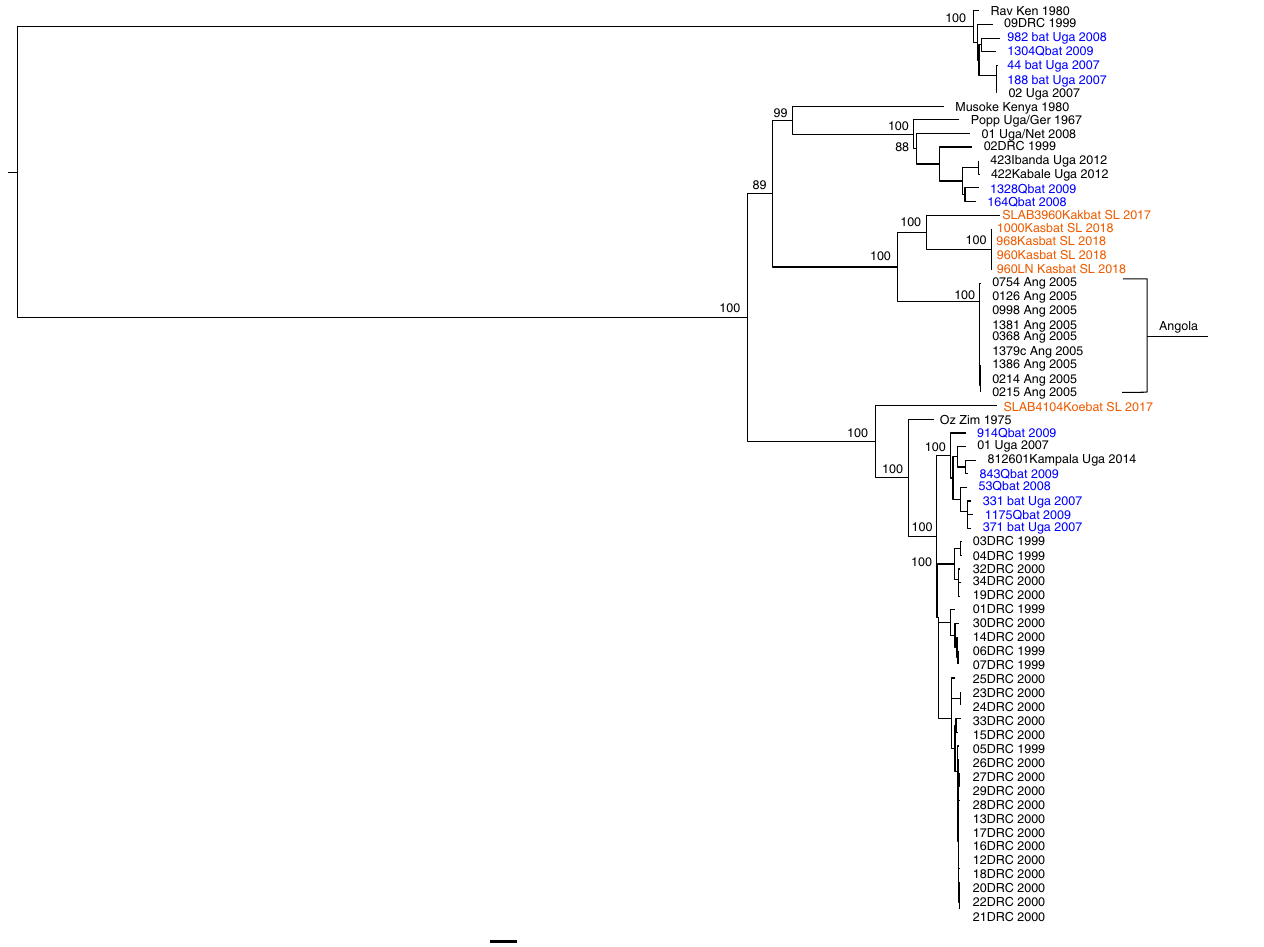
Fig. 3 Mid-point rooted phylogeny of full-length marburgvirus genomes. Maximum-likelihood phylogeny of full-length marburgvirus genomes. Horizontal branch lengths are proportional to the genetic distance between the sequences and the scale at the bottom of the phylogeny indicates the number of nucleotide substitutions per site. Numbers to the left of the nodes represent percent bootstrap values based on 1000 replicates. Only bootstrap values greater than 50% are shown. Sequences in orange represent those generated from the bats in Sierra Leone, sequences in blue represent those generated from bats in Uganda and Gabon and sequences in black represent those generated from human samples. Genbank accession numbers for the Sierra Leone full genome sequences for all Kasbat SL 2017 and Kasbat SL 2018 sequences are as follows: MN187403 — MN187406. Genbank accession numbers for the SLAB3960Kakbat SL 2017 and SLAB410Koebat SL 2017are MN258361 —